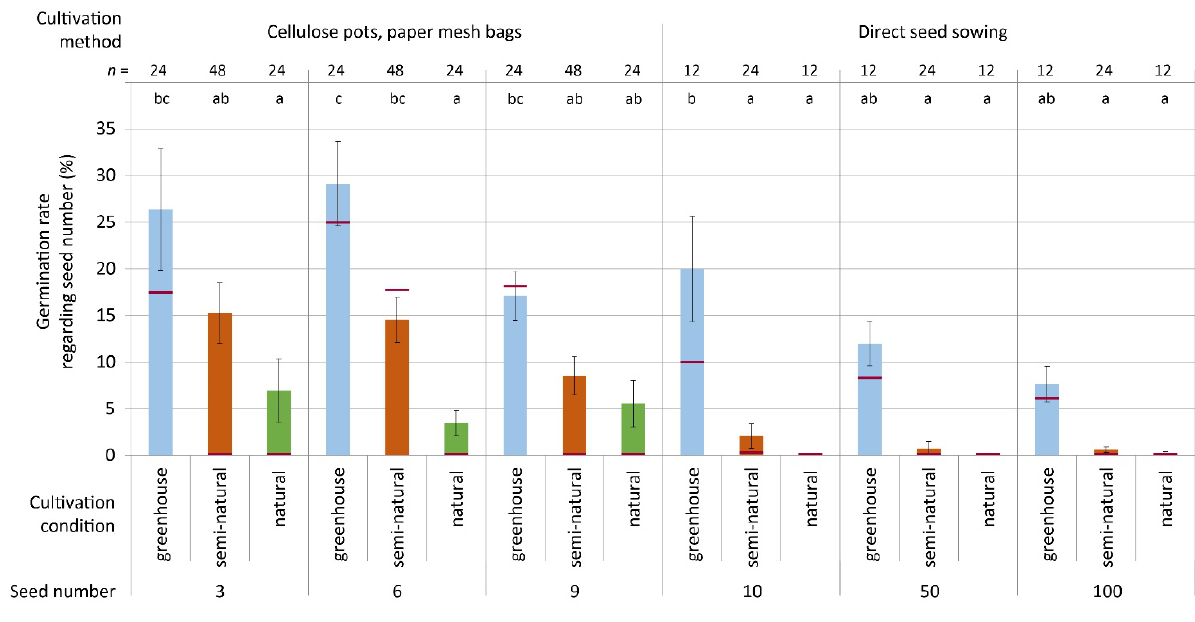
Figure 3. Mean germination rate of Drosera rotundifolia for the different treatments, i.e. cultivation conditions and methods, and seed number. Vertical bars show the means, the whiskers the SE, the red lines the medians. Number of replicates is written above each bar. Values with different letters differ significantly ( P ≤